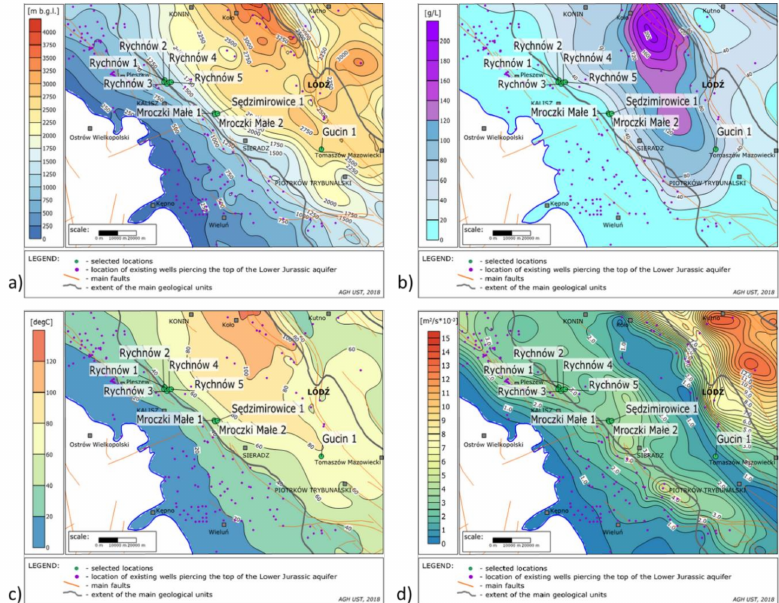
Figure 4. Location of the prospective areas on the background of: ( a ) the base-depth map of the Lower Jurassic geothermal aquifer, ( b ) the water mineralization map of the Lower Jurassic geothermal aquifer, ( c ) the temperature distribution at the top of the Lower Jurassic geothermal aquifer, and ( d ) the transmissivity of the Lower Jurassic geothermal aquifer